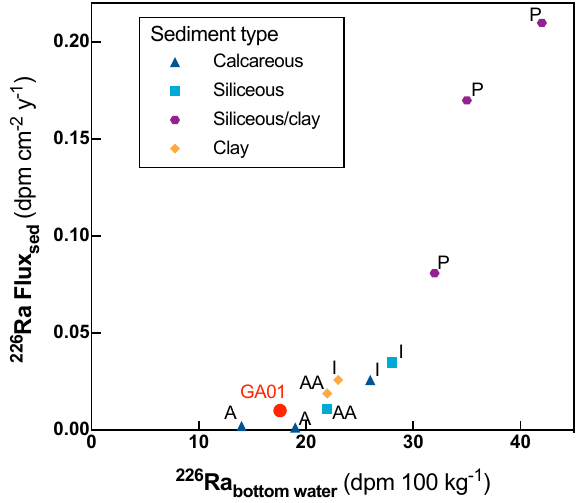
Figure 9. 226 Ra fluxes diffusing out of the sediment in relationship with bottom water 226 Ra activities determined in different oceanic basins (P is Pacific Ocean, A is Atlantic Ocean, I is Indian Ocean and AA is Southern Ocean) by Cochran (1980). The 226 Ra flux calculated in this study to explain the positive anomalies in the West European Basin is also reported (red